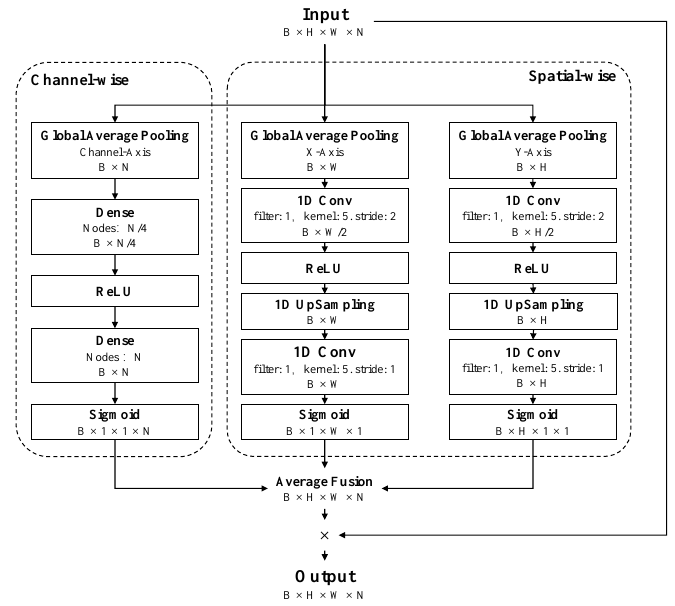
Figure 5. Spatial and Channel Fusion Squeeze-and-Excitation (SCFSE) Module. The Channel-wise branch is used to recalibrate feature map in a channel-wise manner. The Spatial-wise branches are used to recalibrate features on the X-axis and Y-axis,